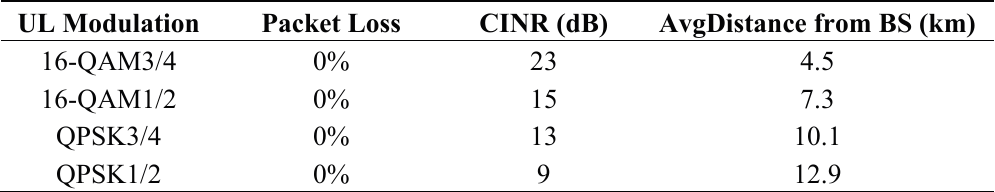
Table 5. WiMAX uplink modulation in